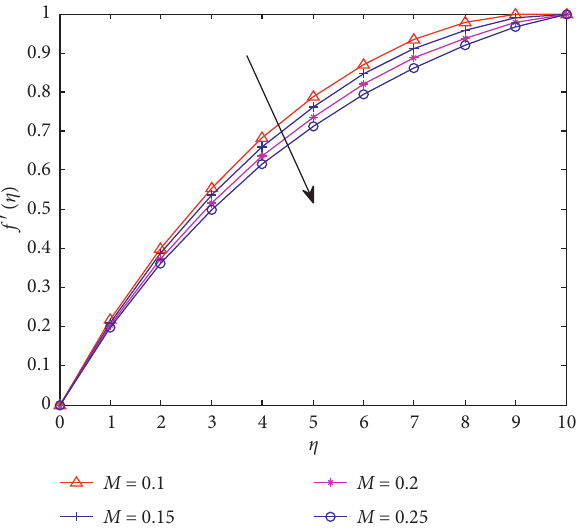
Figure 6: Velocity profiles for various values of the magnetic parameter ( M ) when Pr � 0.72, λ � 0.1, Gr � 0 . 1, M � 0.1, Ra � 0.1, and Bi � 0.1.